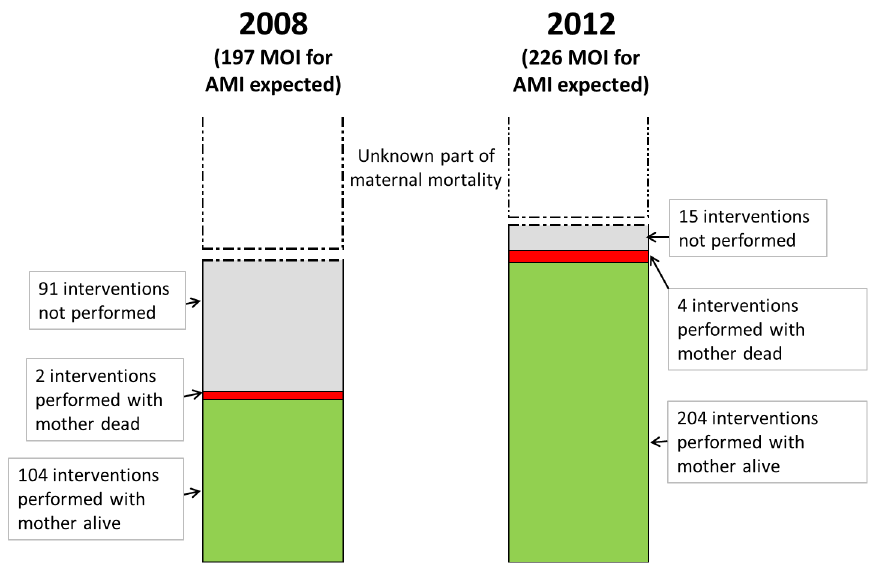
Fig 2. Numbers of women who needed, received (met Obstetric needs) and did not receive (unmet Obstetric needs) MOI for AMI before (2008) and after (2012) the adoption of the policy in the health district of Kissidougou,